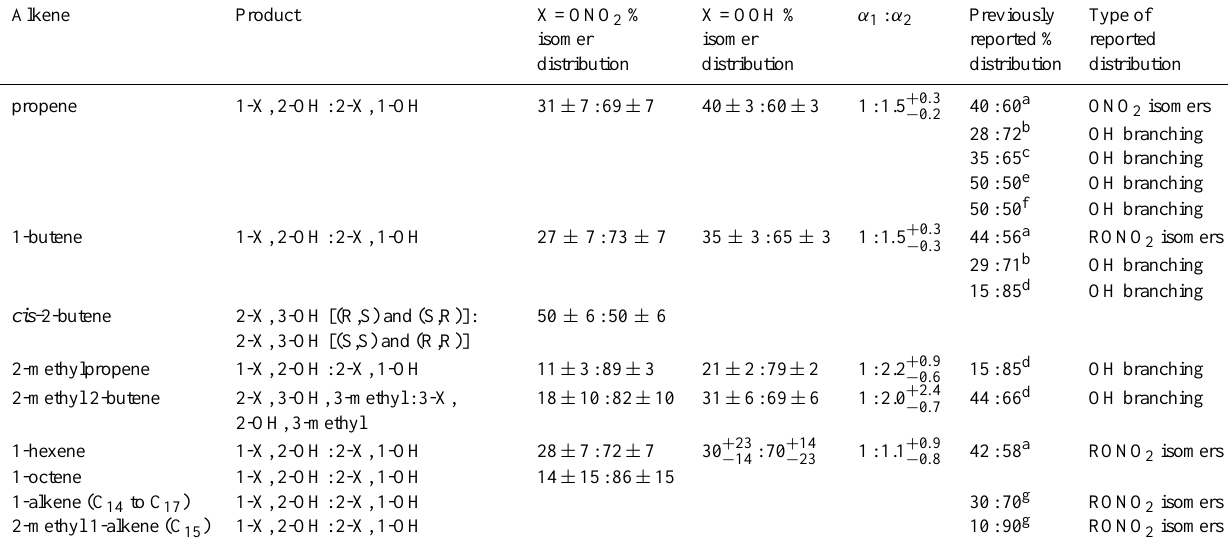
Table 5. Isomer distribution for hydroxy nitrates and hydroxy hydroperoxides formed from OH addition to alkenes. Alkene Product X=ONO 2 % X=OOH % α 1 : α 2 Previously Type of isomer isomer reported % reported distribution distribution distribution distribution propene 1-X, 2-OH:2-X,